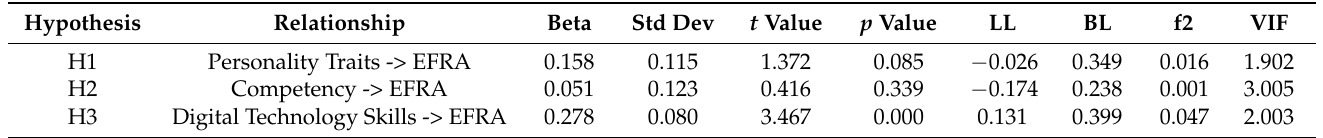
Table 6. Hypothesis